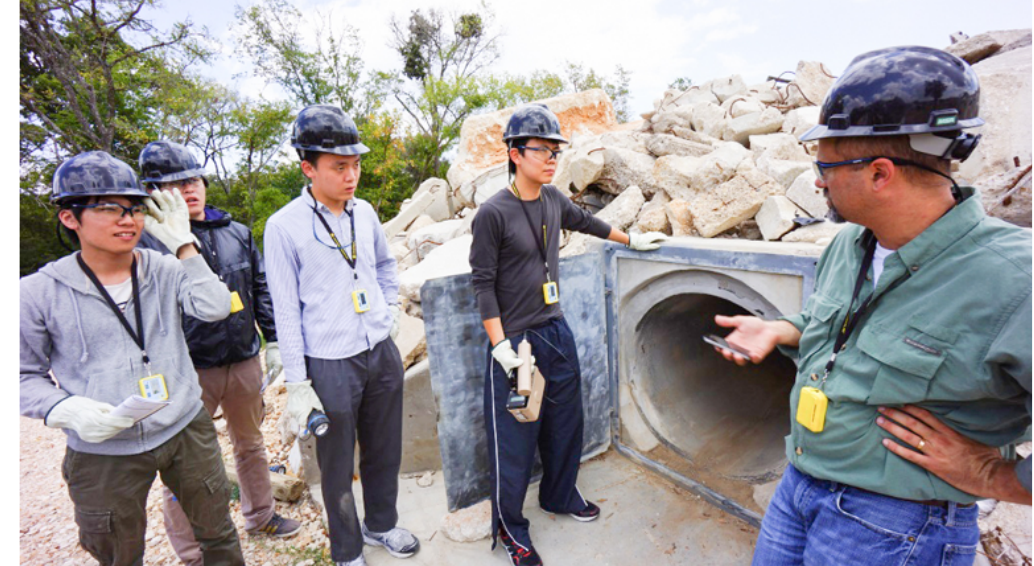
Figure 8. Students from TiTech taking part in an incident response exercise at the TEEX Disaster City